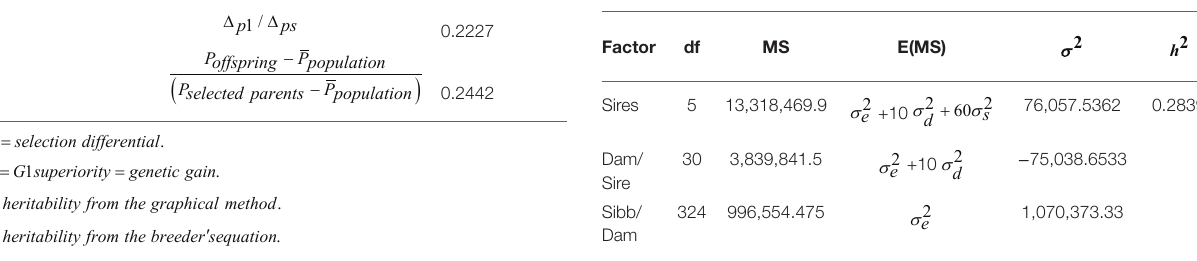
TABLE 4 | Heritability estimate from variance